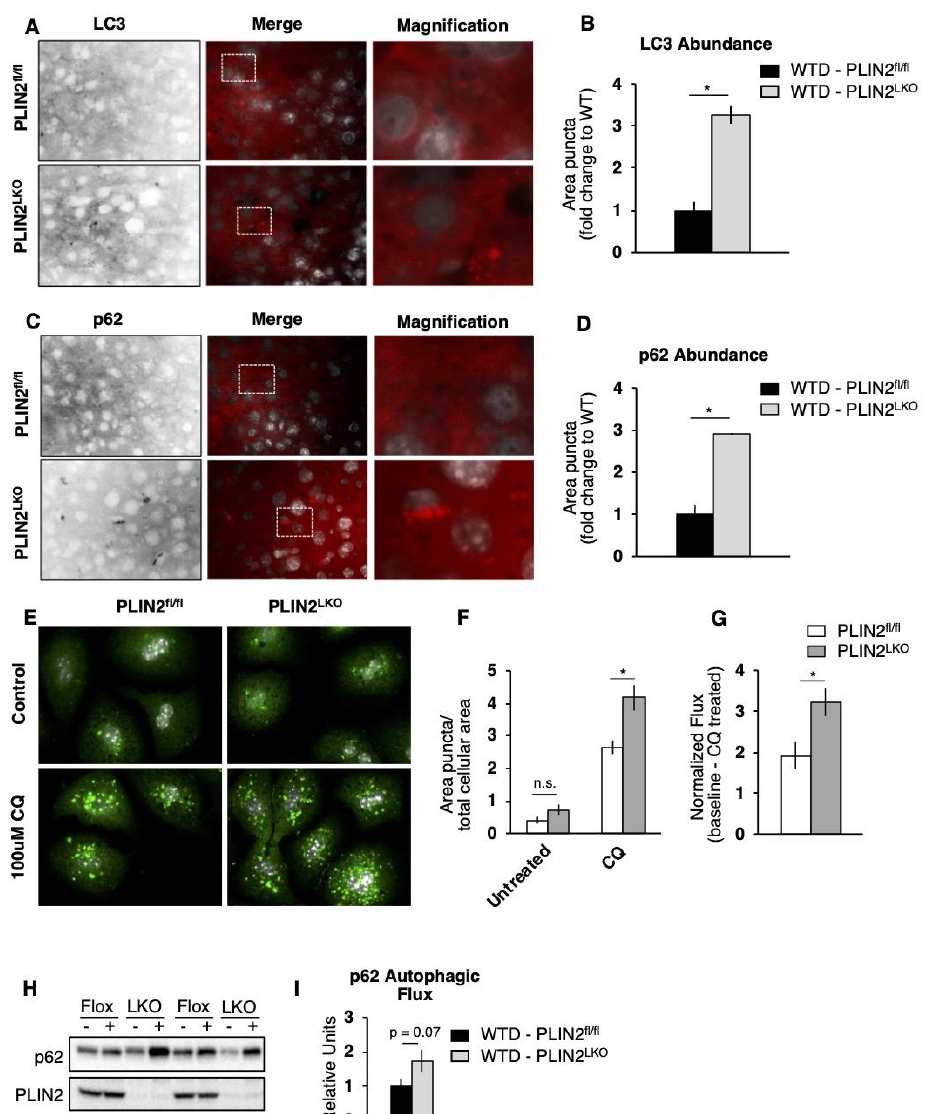
Figure 4. Liver-specific loss of PLIN2 enhances autophagic function. ( A – D ) Immunostaining of autophagic marker LC3 and p62 in frozen liver sections from PLIN2 fl/fl and PLIN2 LKO mice. Representative pictures and quantification of area occupied are shown. Higher magnification images in inverted black and white are shown for better visualization. n = 3. ( E ) Immunostaining and ( F , G ) quantitation of autophagic flux of the autophagosomal marker LC3 in fixed primary hepatocytes isolated from 8-month-old mice and incubated in M199 media in the presence or absence of 100 µM CQ for 6 h. ( H ) Representative blot and ( I ) densitometric quantitation of p62 autophagic flux from livers isolated from male mice fed HFD for 12 weeks and treated with (+) and without ( – ) autophagic inhibitors ex vivo. Flux is determined as the difference between treated and untreated p62 protein abundance and expressed relative to PLIN2 fl/fl , n = 7. * p ≤ 0.05 , as determined by one-way ANOVA and Tukey’s post hoc analysis.